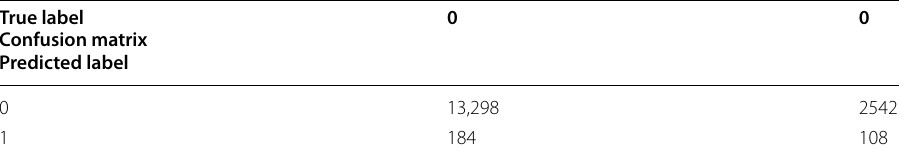
Table 1 “Confusion Matrix” of this experiment’s classification